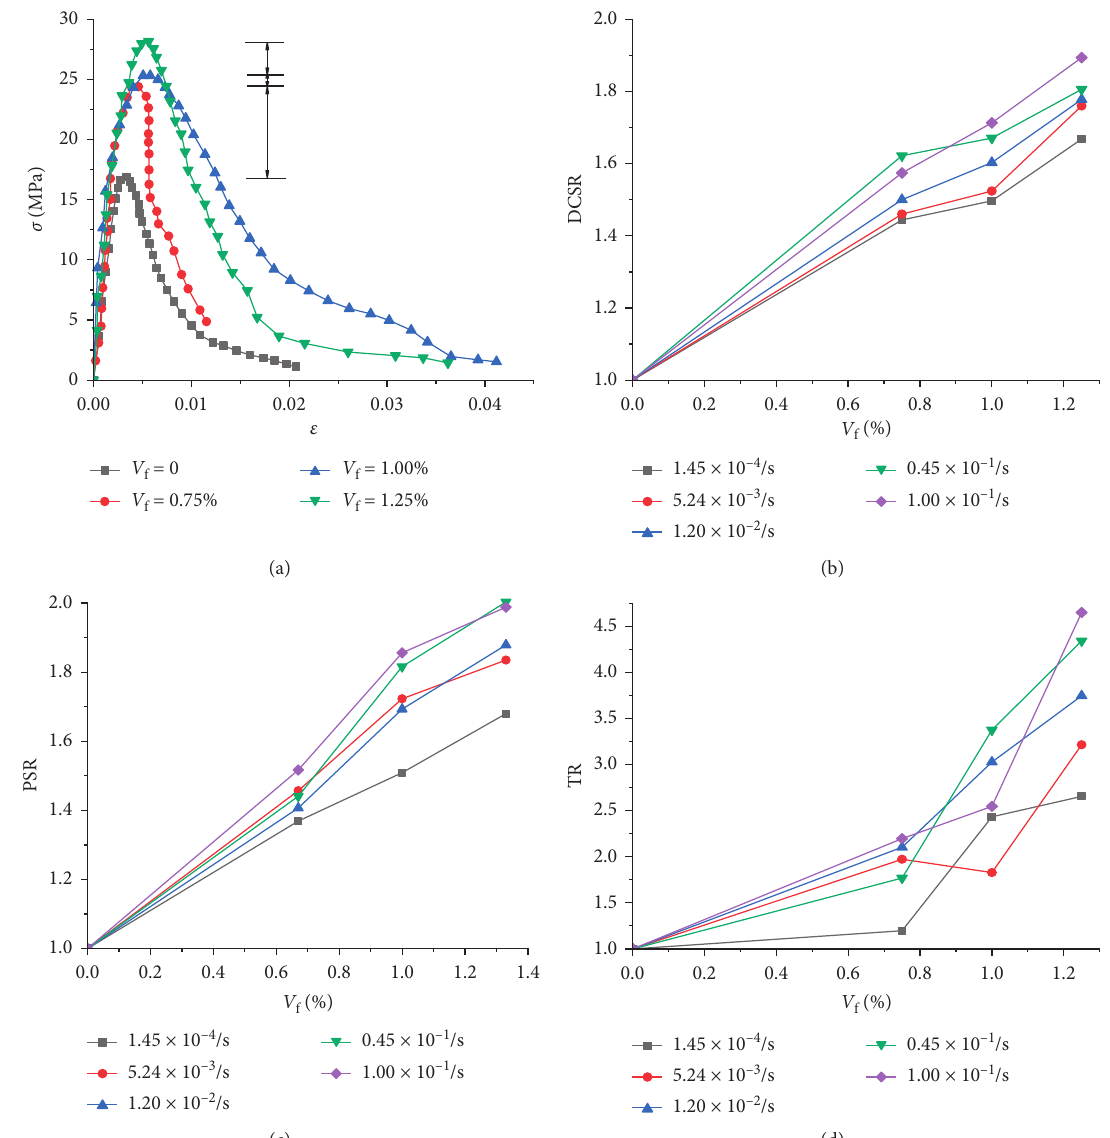
Figure 7: (a) Dynamic compressive stress-strain curves of SFRC at _ ε � 1 . 45 × 10 − 4 /s. (b) Relationship between steel fiber content ( V DCSR of SFRC. (c) Relationship between steel fiber content ( V f ) and PSR of SFRC. (d) Relationship between steel fiber content ( V f ) and TR of